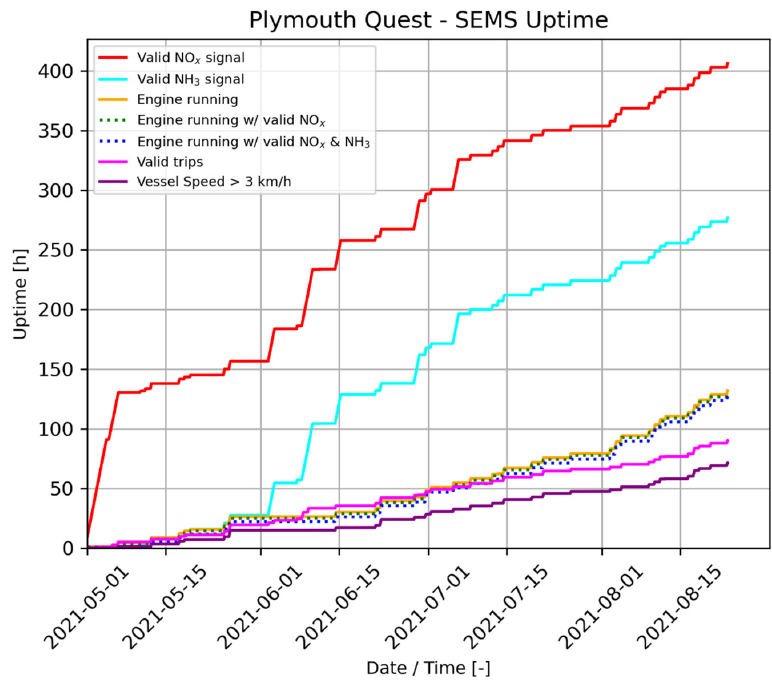
Figure 6. Uptime of several components of the SEMS onboard the RV Plymouth Quest .